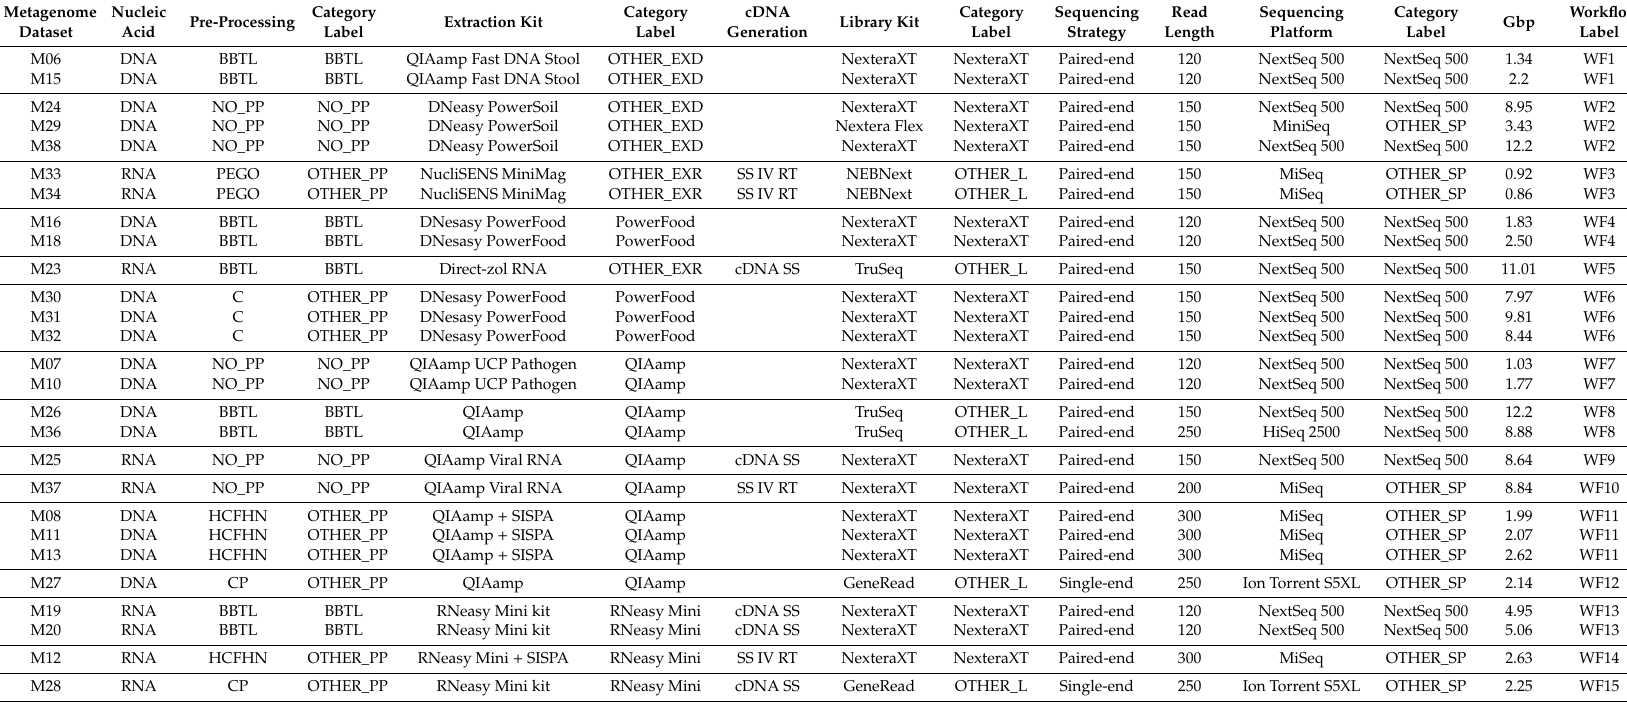
Table 2. Metagenomic datasets and corresponding wet-lab protocols. All protocols are detailed in the Supplementary Materials. Pre-processing protocols were bead beating based protocols with TissueLyser (BBTL), no-processing (NO_PP), extraction with chloroform / butanol, Cat-Floc T, OmniCleave Endonuclease (PEGO), centrifugation (C), liquid nitrogen, centrifugation and filtration in HPF Millex filter (HCFHN), and CryoPrep Covaris (CP). The pre-processing protocols were categorized for the biostatistical analysis as no-processing (NO_PP), bead beating based protocols using TissueLyser (BBTL) and other pre-processing protocols (OTHER_PP). The DNA was extracted by QIAamp Fast DNA Stool and DNeasy Power Soil (categorized as OTHER-EXD), DNeasy Power Food Microbial Kit (PowerFood), QIAamp DNA Mini Kit with or without Sequence-Independent, Single-Primer-Amplification (SISPA), and QIAamp UCP Pathogen Mini Kit (categorized as QIAamp). The RNA was extracted by the RNeasy Mini Kit with or without TRIzol and SISPA (categorized as RNeasy Mini), QIAamp Viral RNA Mini Kit (QIAampV), NucliSENS ® miniMAG ® and Direct-zol RNA Kit (categorized as OTHER_EXR). The cDNA was generated using the cDNA Synthesis System Kit (cDNA SS) or the